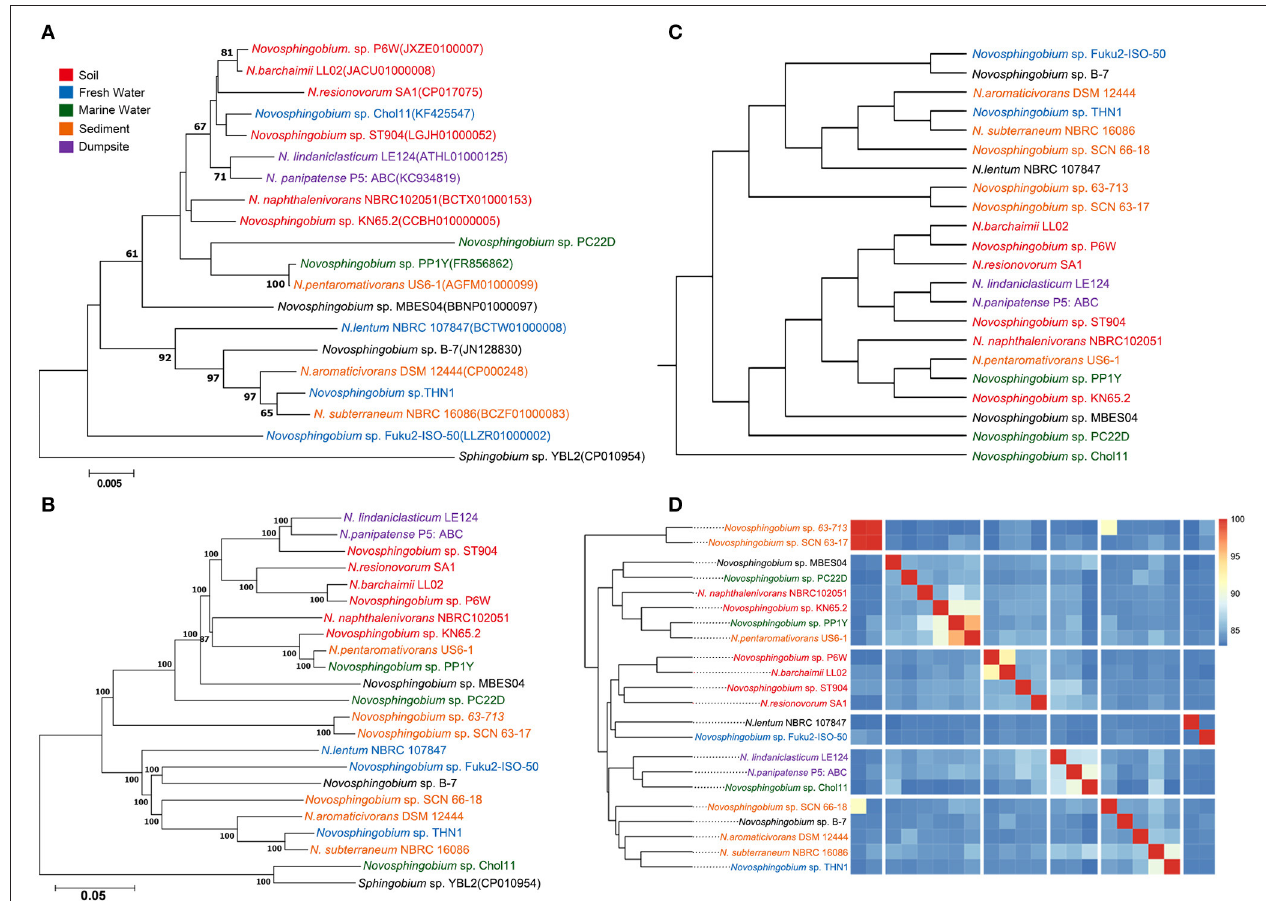
FIGURE 1 | Phylogenetic relationships of 22 Novosphingobium strains . Phylogenetic trees based on (A) 16S rRNA gene sequences and (B) 674 core genes with 1000 bootstraps with Sphingobium sp. YBL2 as an outgroup. The bars represent the number of substitutions per nucleotide position. Percentage bootstrap values ( ≥ 50%) are shown next to the nodes. (C) Whole-genome-based phylogeny trees using a composition vector (CV) approach. (D) Average nucleotide identity (ANI)-based phylogenetic dendrograms showing hierarchical clustering of